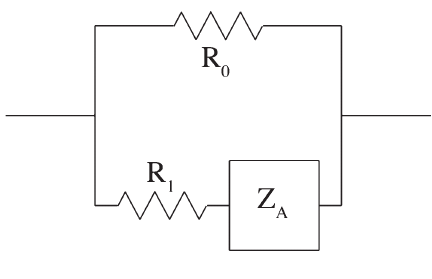
Fig. 3. A typical biological tissue circuit model. Z A is a constant- phase element, and R 1 in parallel with R 0 equal R 8